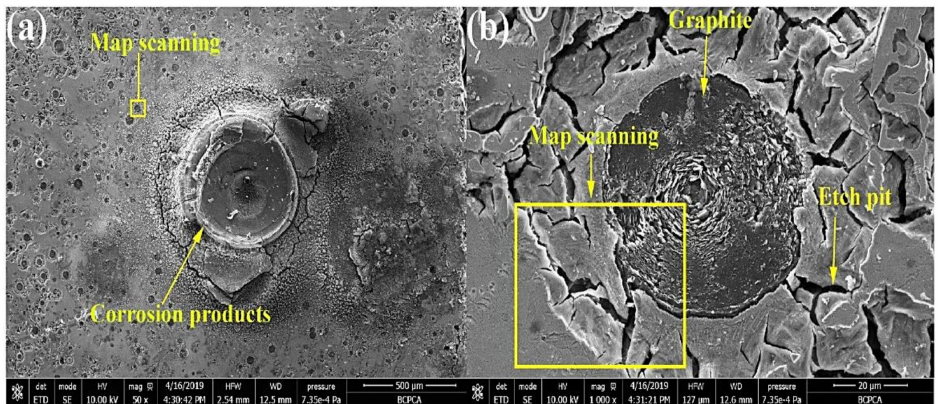
Figure 14. Morphological structures of carbidic austempered ductile iron after corrosion in an acidic environment solution [40]. ( a ) body-centered cubic (BCC) structure, ( b ) face-centered cubic (FCC)